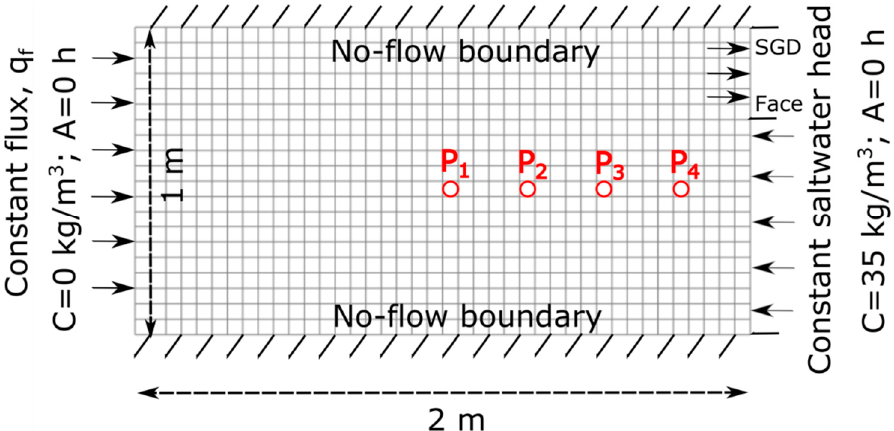
Figure 1. Sketch of the Henry problem showing flow, transport, and direct age boundary conditions on the upstream freshwater and downstream seawater boundaries, respectively. Observation points P 1,…,4 are indicated in red